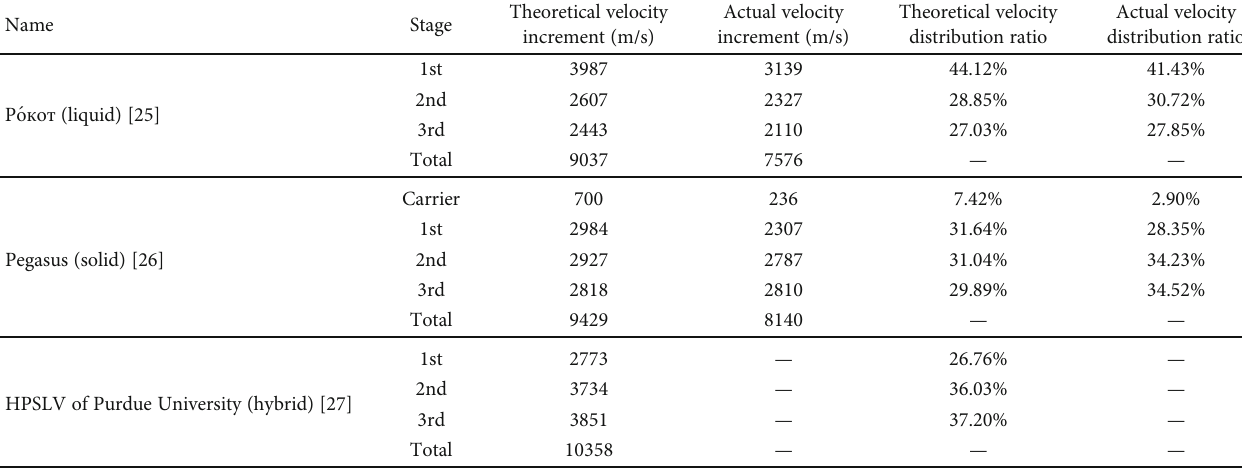
Table 11: Velocity increments and velocity distribution ratios of several typical three-stage